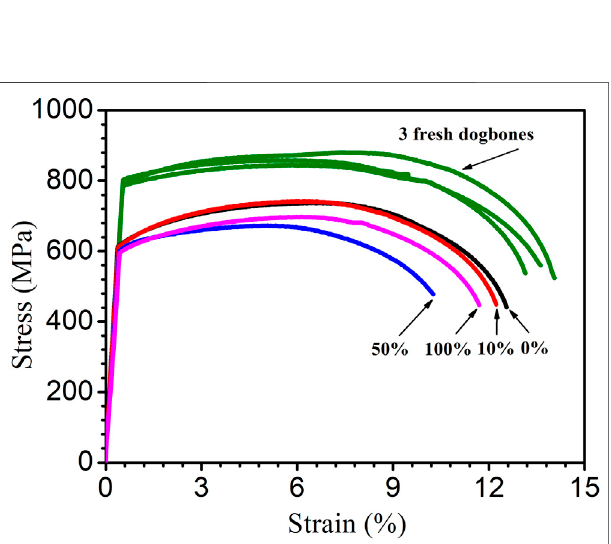
FIGURE12| Pitdepthpro fi lesfordogbonecouponsafter14-daysstarvationincubationwiththecarbonsourcelevelof: (A) 0%, (B) 10%, (C) 50%, (D) 100%,and with (E) fresh dogbone (control).